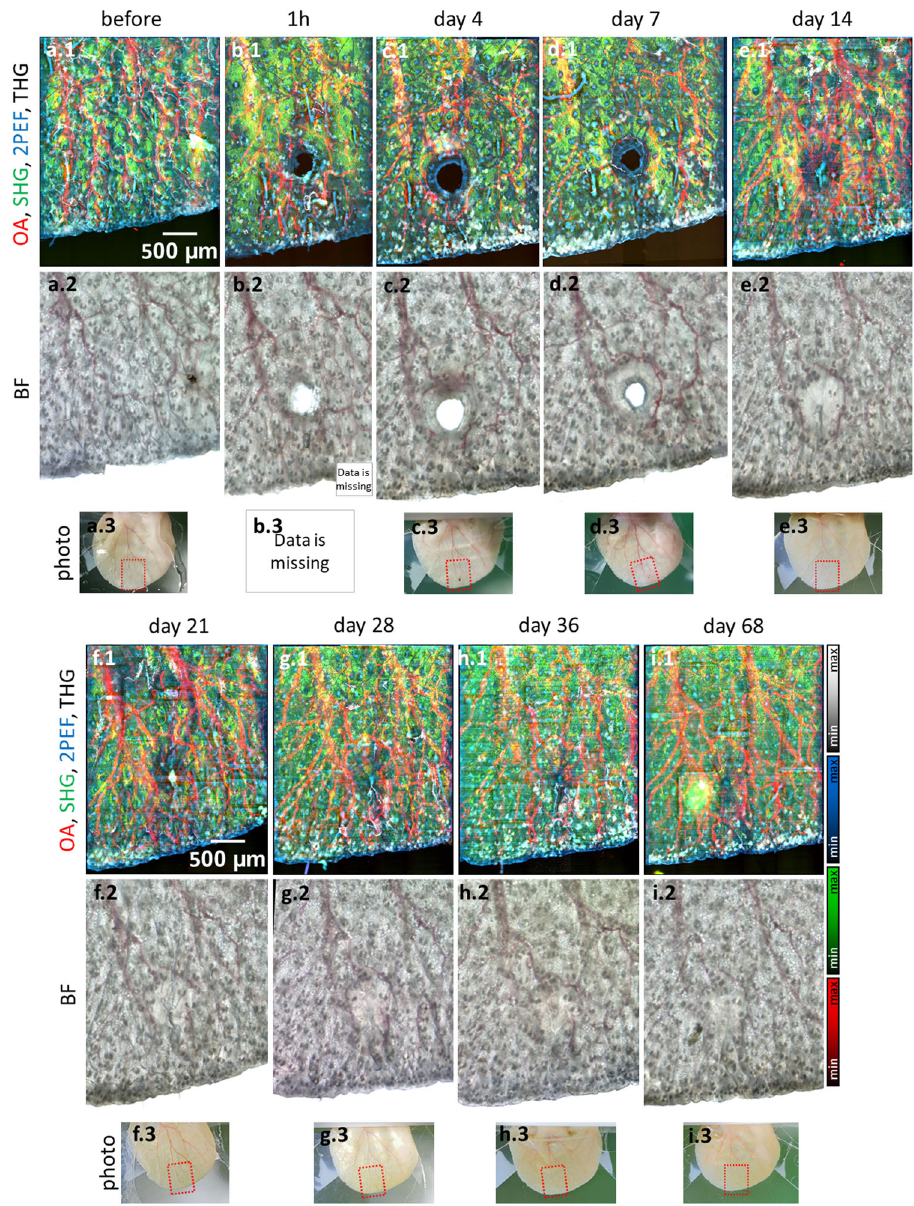
Fig. 3 Longitudinal imaging of the wound healing process in a mouse ear in vivo by label-free multimodal microscopy achieved using Co5M. a.1 Multimodal image of the mouse ear before wound in fl iction and corresponding a.2 bright fi eld microscopy image as well as a.3 photograph of the ear. Analogous depiction of the ear at b.1 – 3 1 h, c.1 – 3 4 days, d.1 – 3 7 days, e.1 – 3 14 days, f.1 – 3 21 days, g.1 – 3 28 days, h.1 – 3 36 days, and i.1 – 3 68 days after wound in fl